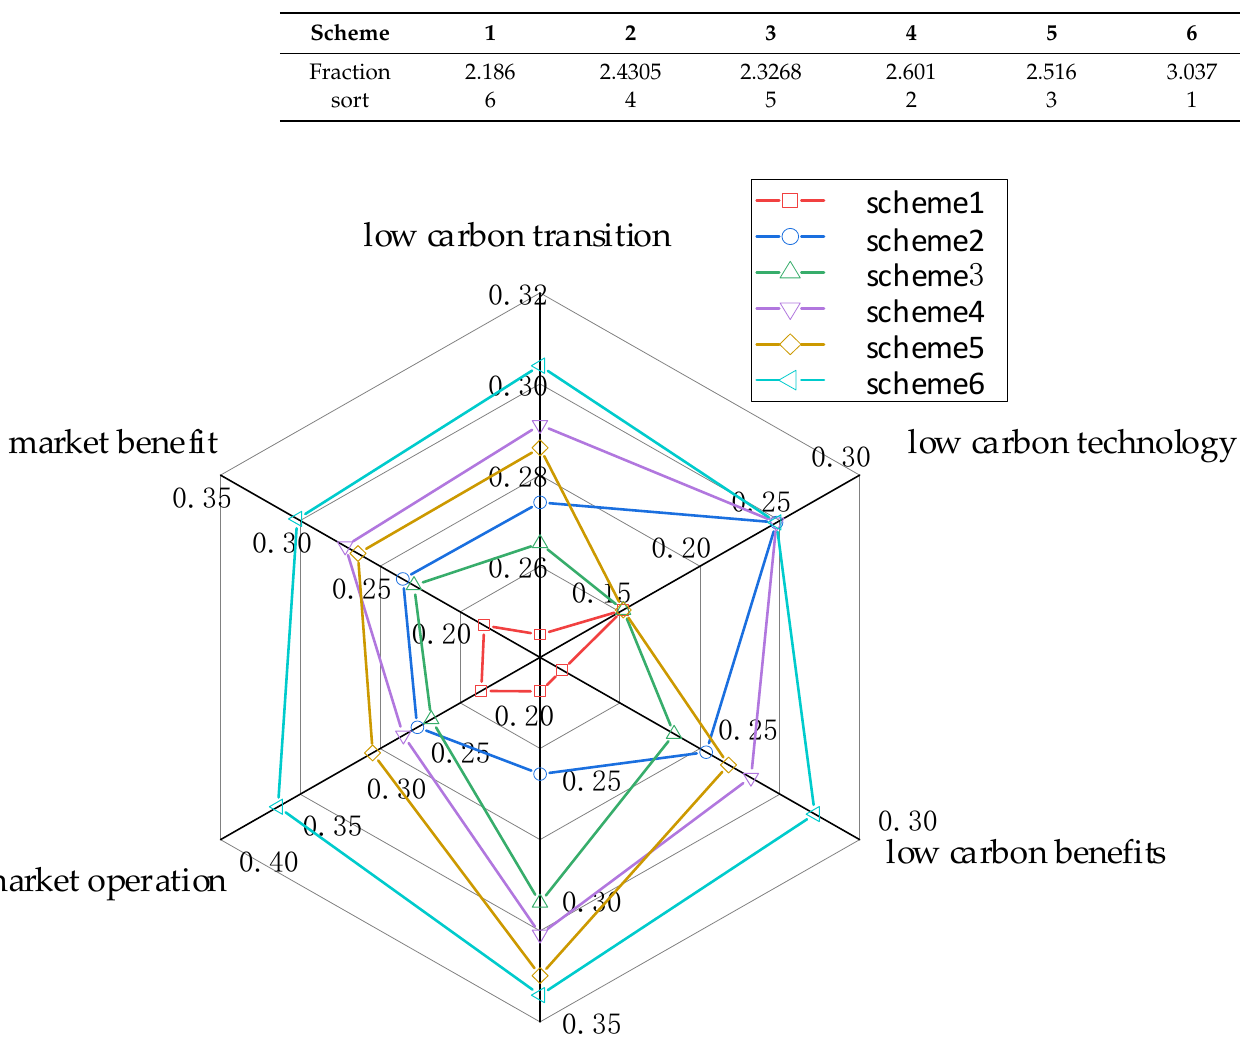
Figure 9. Radar chart of secondary index evaluation results.